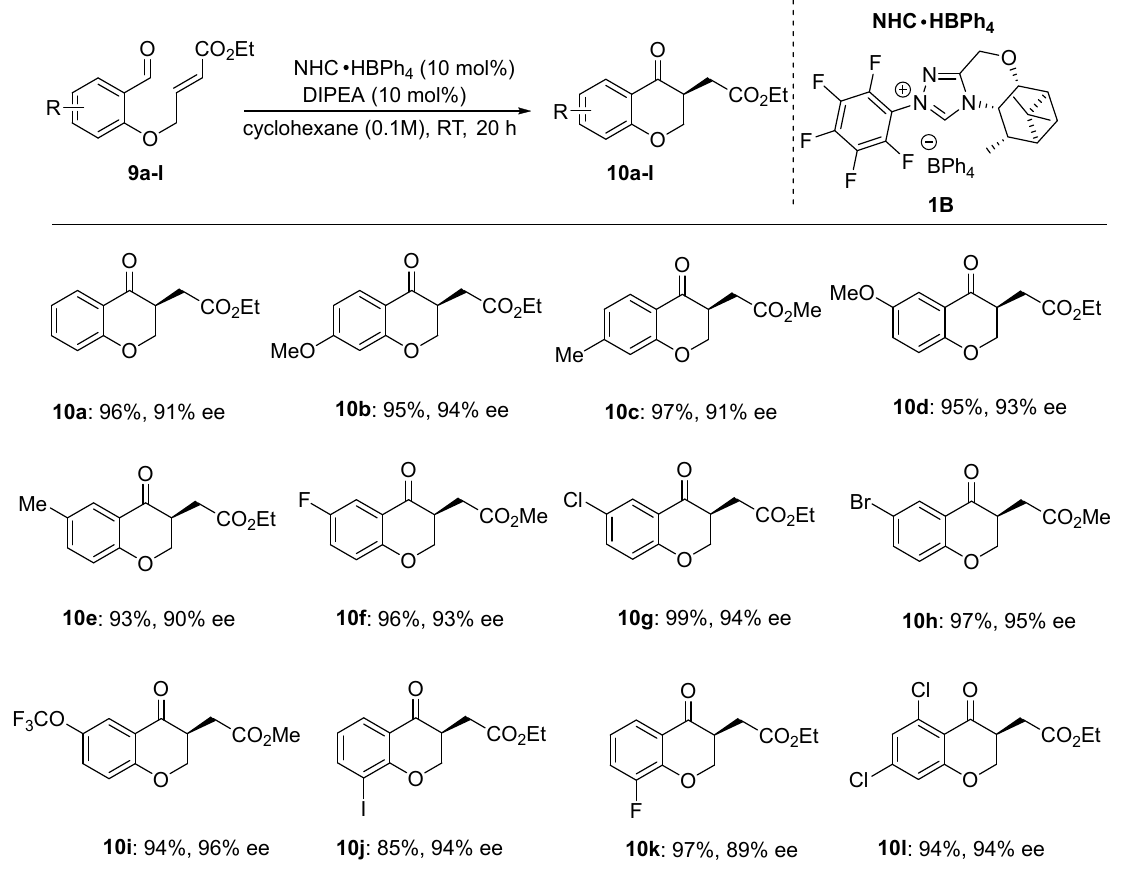
Table 4. Substrate scope for enantioselective intramolecular Stetter reaction.